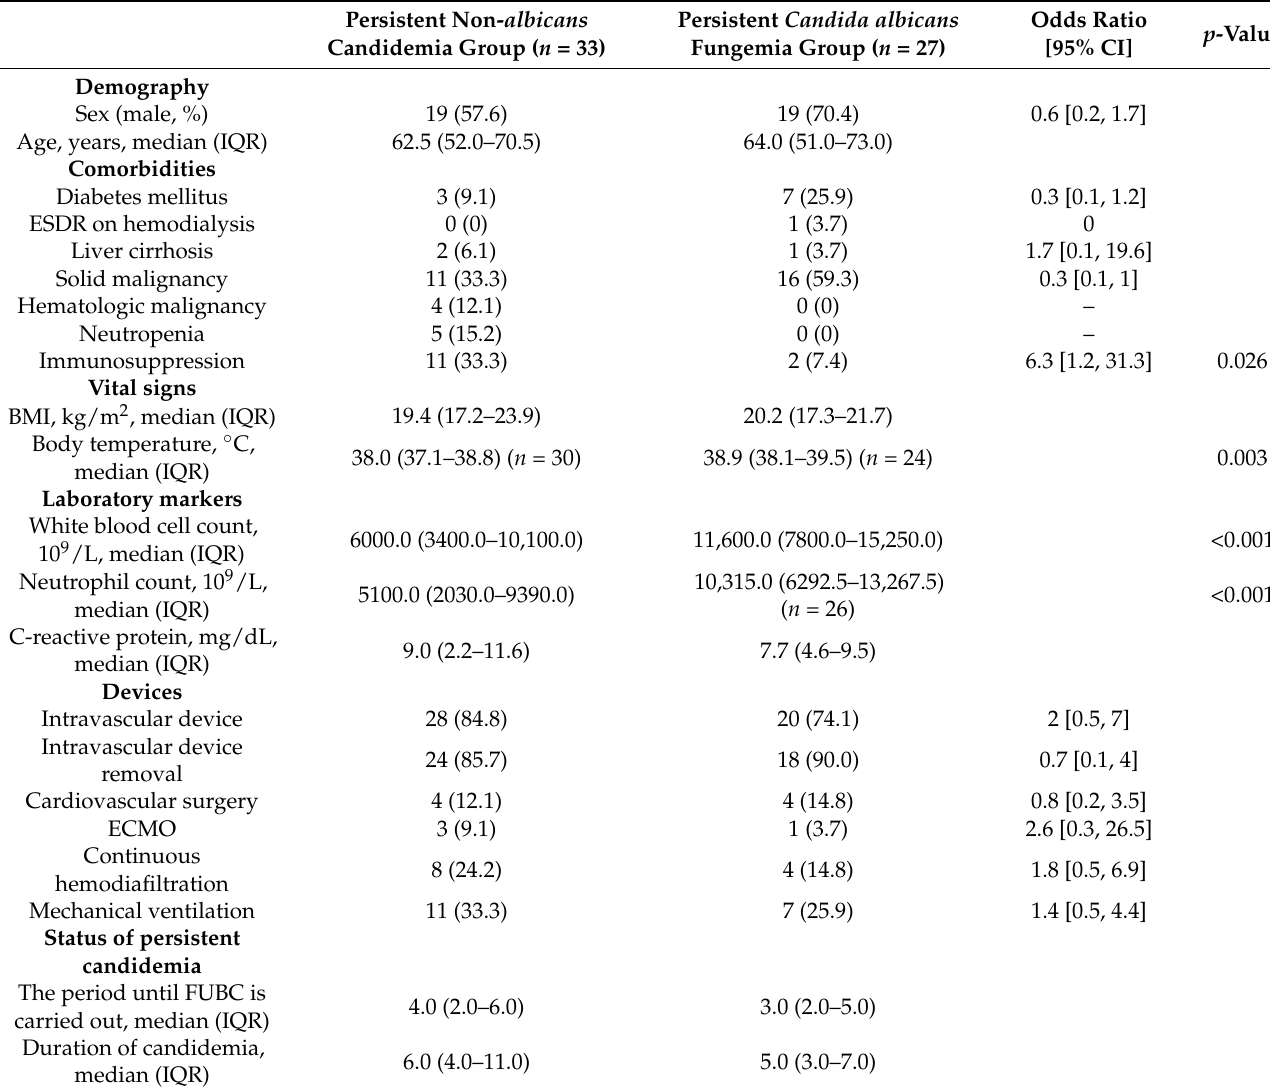
Table 1. Clinical characteristics of hospital-acquired persistent candidemia caused by Candida albicans and non-albicans Candida